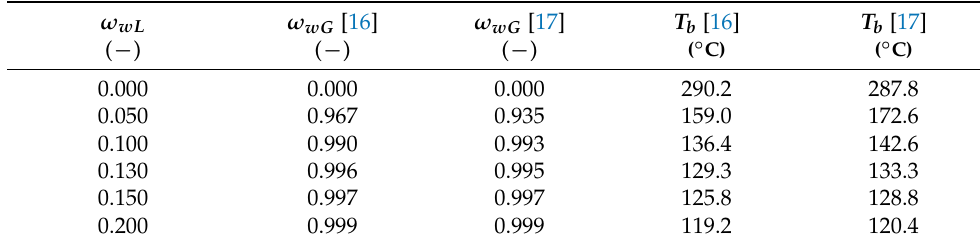
Table 3. Vapor–liquid equilibriums with bubble-point temperature T b predicted with models of Mokbel et al. [16] and Soujanya et al.